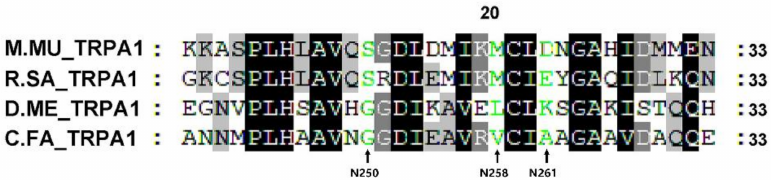
Figure 7. Multi-sequence comparison of the ANK6 in TRPA. The black background represents the same amino acid, the gray background represents similar amino acid, and the green represents the amino acid at the mutation site. M.M, M.musculus; R.SA, Pantherophis obsoletus lindheimeri; D.ME, D. melanogaster ; C.FA , C. farreri